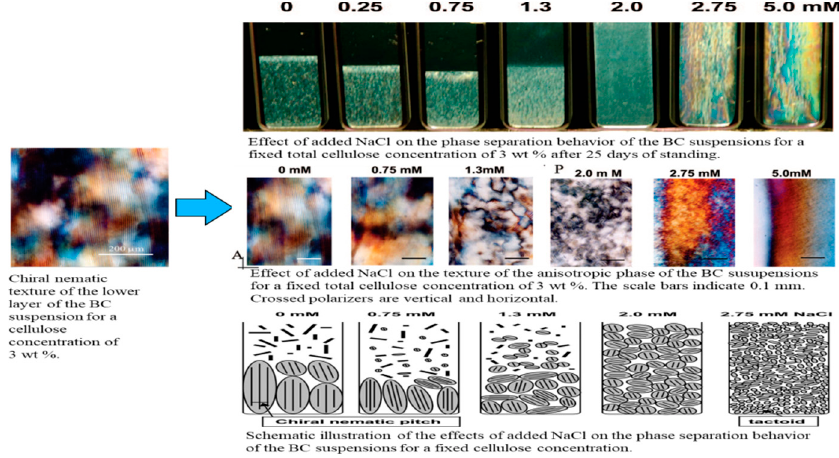
Figure 3. Schematic illustration of phase separation behavior of the bacterial cellulose (BC) suspensions. Reprinted with permission from Ref. [65]. Copyright 2009 American Chemical Society. Among inorganic acids, hydrochloric acid (HCl), sulfuric acid (H 2 SO 4 ), and a mixture of HCl and H 2 SO 4 are usually used. The properties of BCNCs from acid hydrolysis are shown in Table 3.